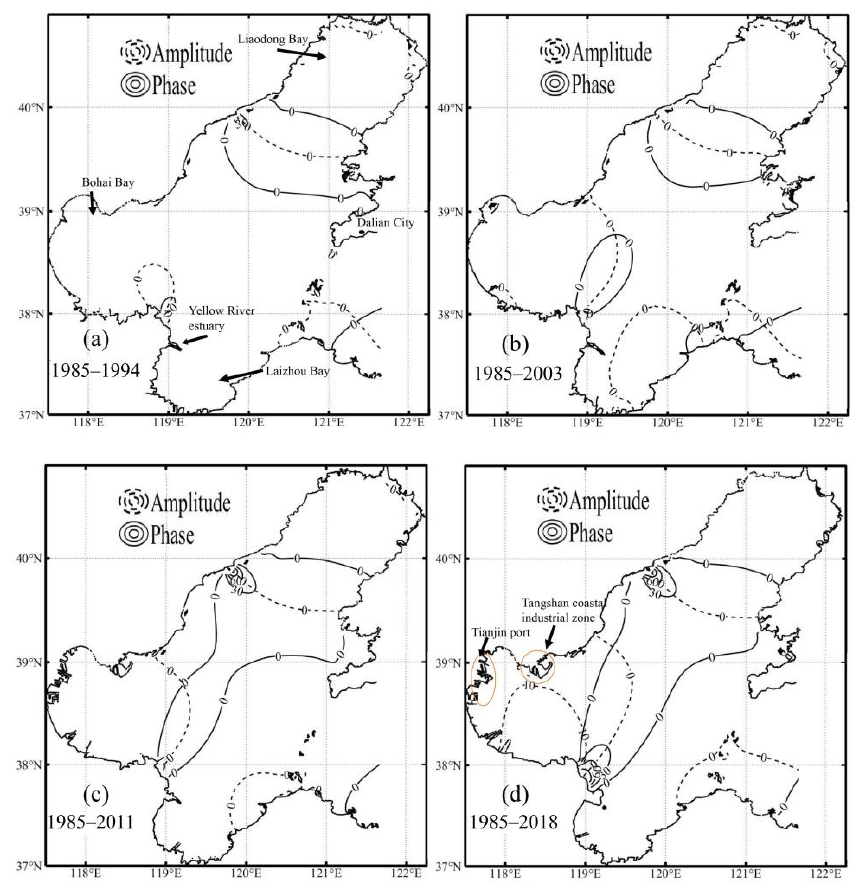
Figure 10. The differences in phase during four periods. The solid black lines denote the differences in amplitude (cm), and the dotted black lines denote the differences in phase (°).